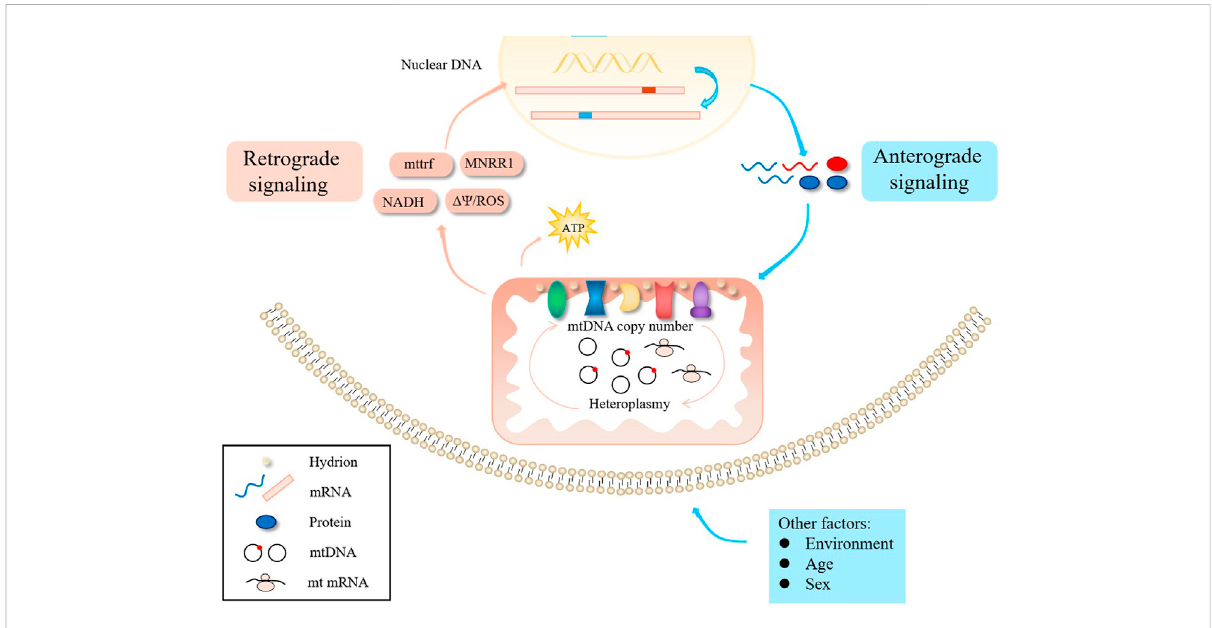
FIGURE 2 In fl uencing factors of clinical